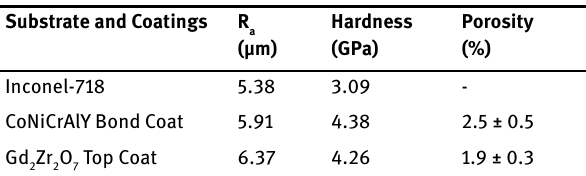
Table 2: Roughness, hardness and porosity values of substrate and